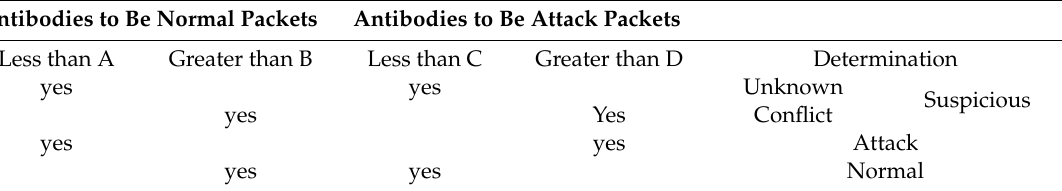
Table 7. Illustration of the determination ranges from Figure 9.